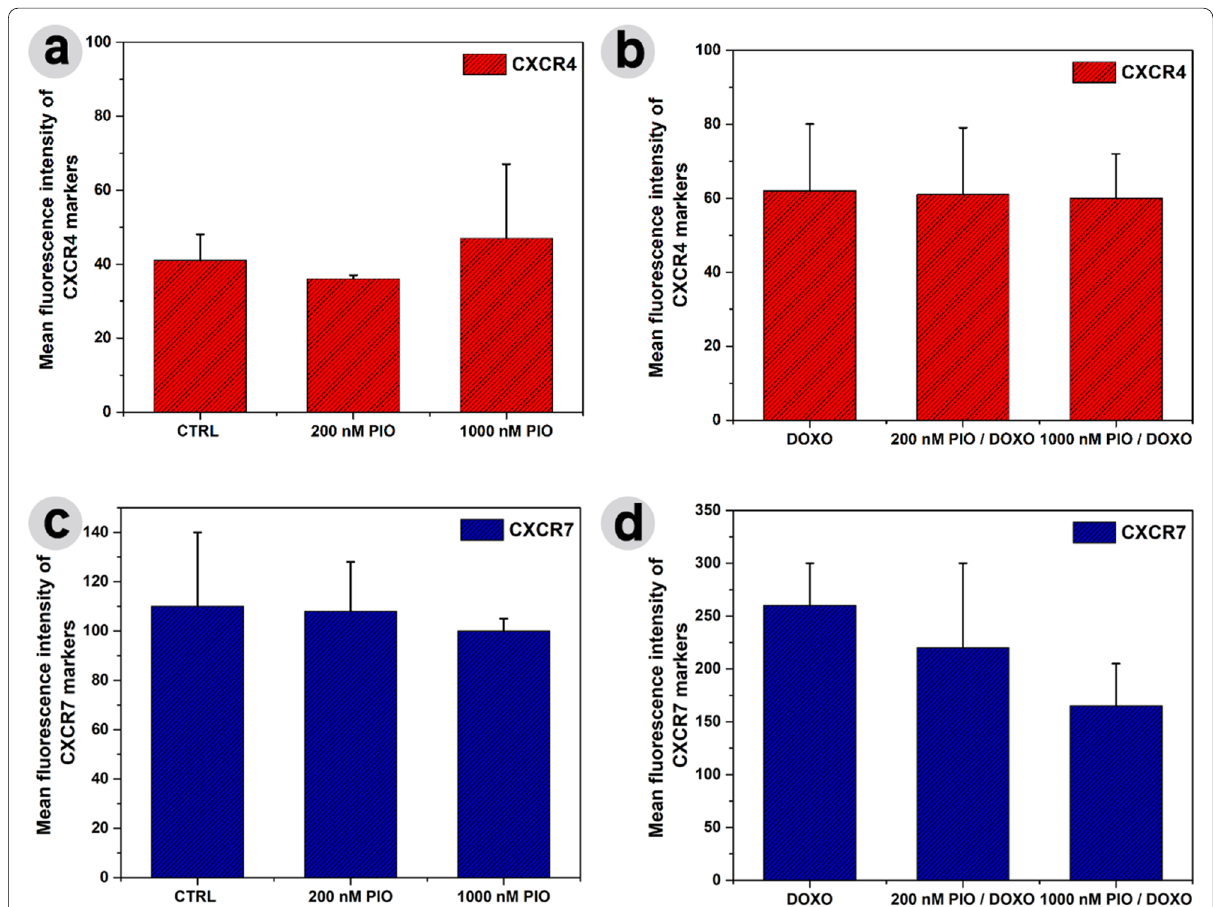
Fig. 2 Results of CXCR4 and CXCR7 marker expressions on the cell surface by flow cytometry technique after 21 days of drug treatment. a The expression of CXCR4 markers on cells receiving 200 and 1000 nM PIO compared to control cells. b The CXCR4 markers expressed on cells receiving DOXO with each dose of PIO simultaneously and compared to DOXO-treated cells alone. c The expression of CXCR7 markers on control cells. d The CXCR7 markers expressed on main cells receiving DOXO and PIO simultaneously and compared to DOXO-treated cells alone ( P >